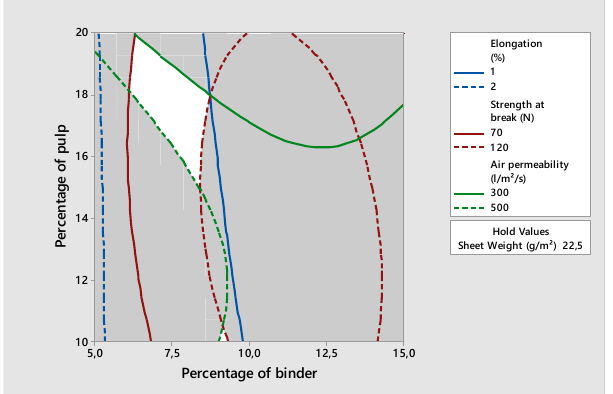
Figure 7. Diagram of the superposed contours.